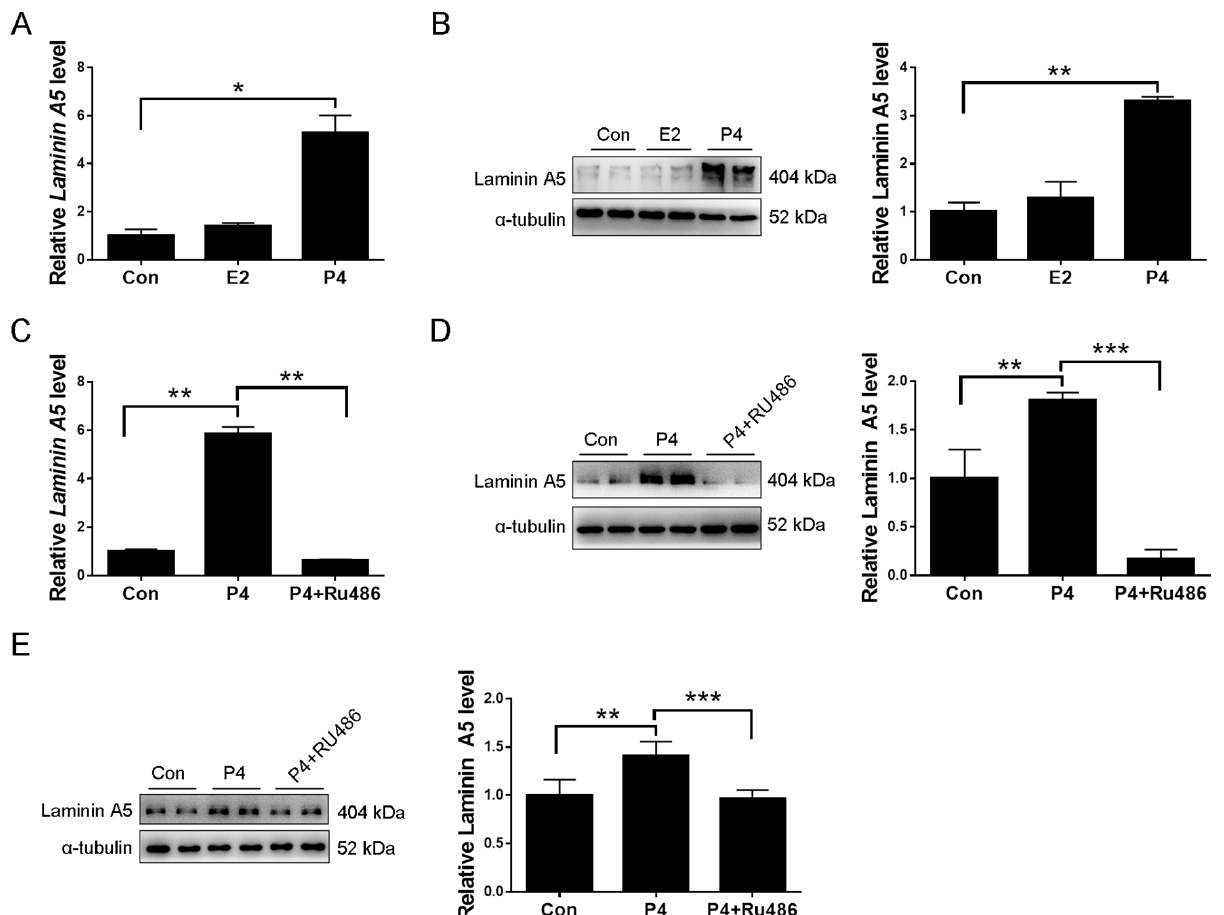
Figure 4. Progesterone regulation of laminin A5 in uterine stromal cells. ( A ) RT-qPCR analysis of Laminin A5 levels after stromal cells were treated with 1 mM progesterone or 10 nM 17 β -estradiol for 72 h. ( B ) Western blot analysis of laminin A5 protein levels after stromal cells were treated with progesterone or 17 β -estradiol for 72 h. ( C ) Effects of RU486 on progesterone-stimulated Laminin A5 expression. ( D ) Western blot analysis on the effect of RU486 on progesterone-stimulated laminin A5 protein level. ( E ) Western blot analysis of effects of RU486 on progesterone induction on laminin A5 expression in ovariectomized mouse uteri. Bars represent mean ± SD (* p -value < 0.05, ** p -value < 0.01, *** p -value < 0.001). P4, progesterone; E2, 17 β‐ estradiol.